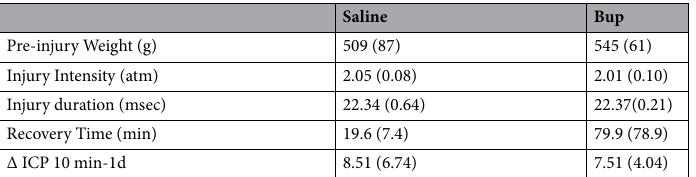
Table 1. Physiological readouts in buprenorphine and saline treated animals prior to and following cFPI. g, grams; atm, atmospheric pressure; BPM, beats per minute; Δ ICP 10 min-1d, change in intracranial pressure from 10 min post-injury to 1d post-injury. n = 6 rats/group. Data presented as mean (standard